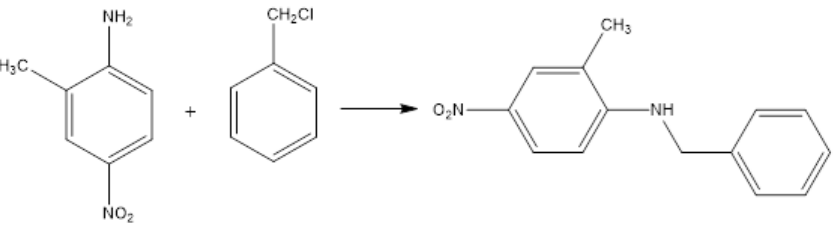
Figure 3. Schematic diagram of BNA